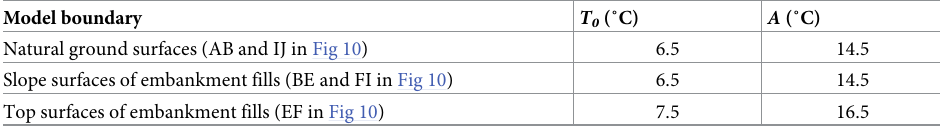
Table 4. Thermal boundary conditions used in railway embankment modeling.